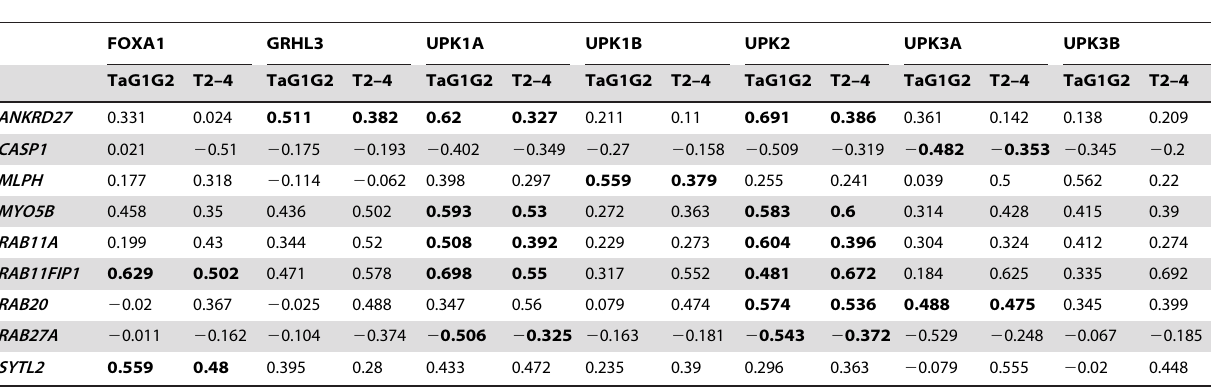
Table 6 . Deregulated genes correlated with differentiation